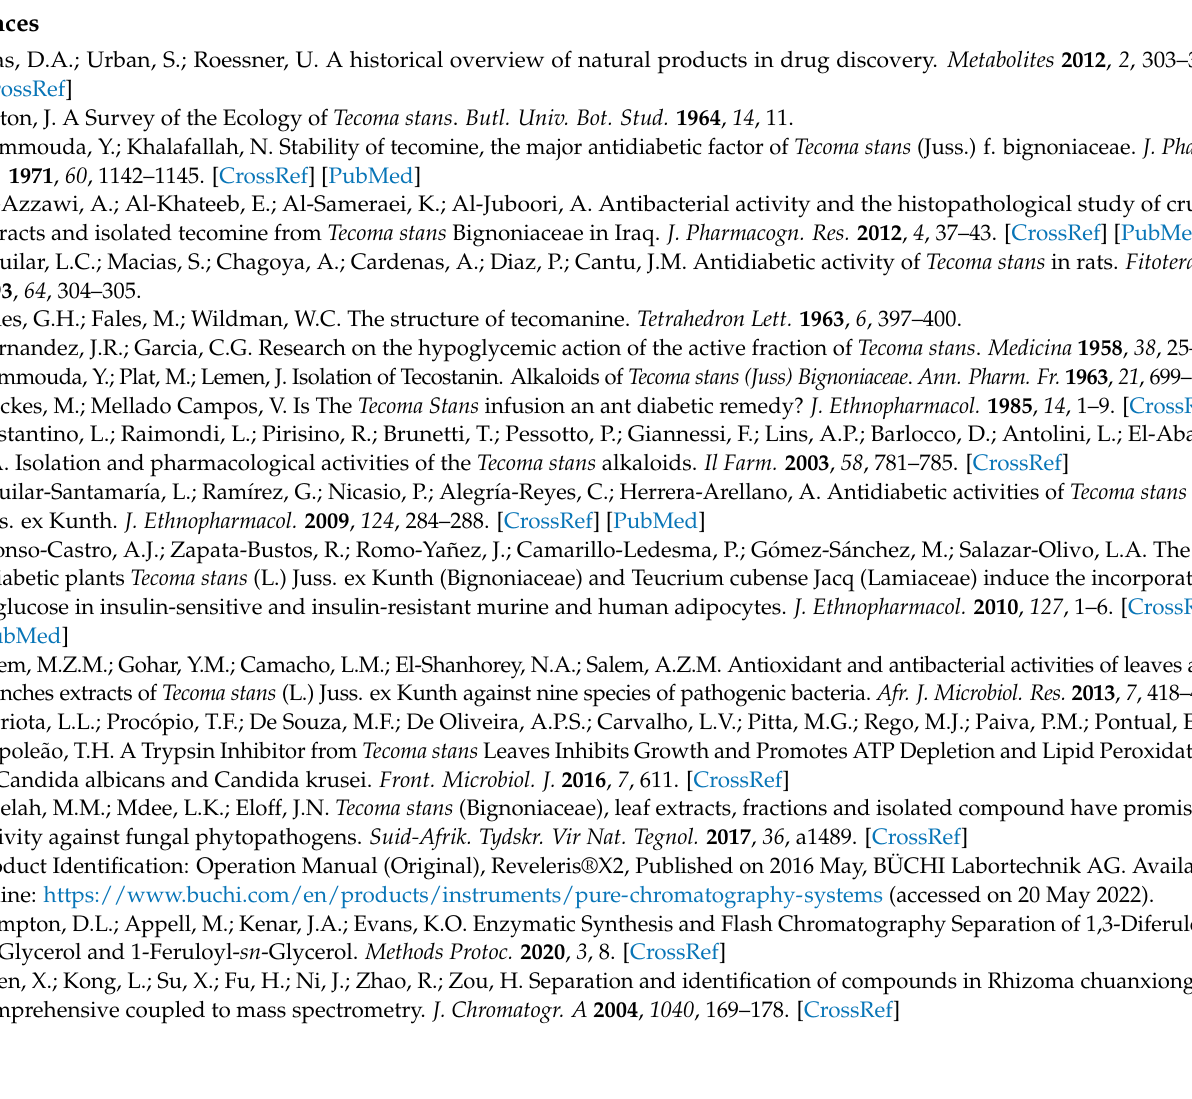
(HMBC) Spectrum, Figure S2: Heteronuclear single quantum Correlation (HSQC) Spectrum for Fraction A-3, Figure S3: Homonuclear correlation spectroscopy (COSY) Spectrum for Fraction A-3, Figure S4: Total correlated spectroscopy (TOCSY) Spectrum. Table S1: Method development for the ethanolic